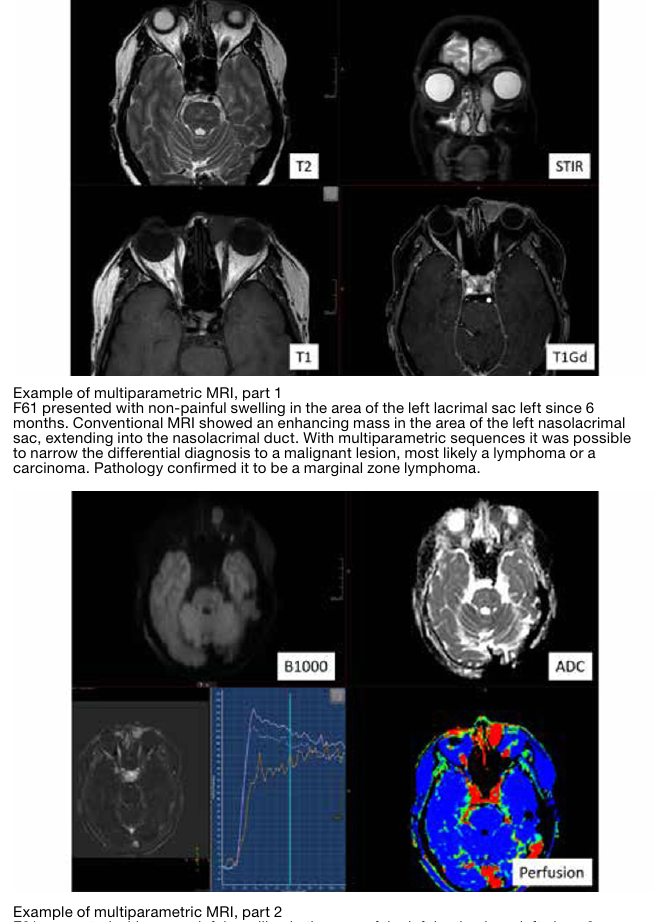
F61 presented with non-painful swelling in the area of the left lacrimal sac left since 6 months. Conventional MRI showed an enhancing mass in the area of the left